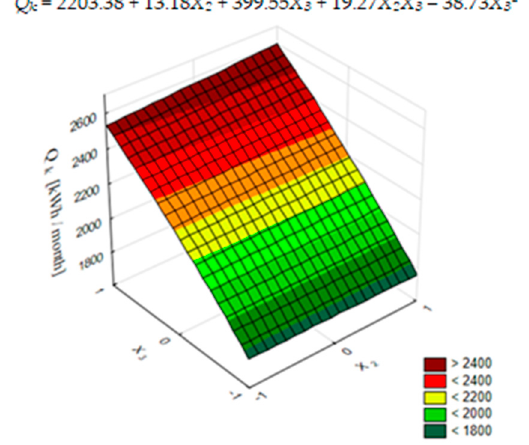
Figure 13. Dependence of the monthly final energy demand Q k (kWh / month) of the tested building on the length of the residents’ self-isolation period τ (factor X 2 ) and number of residents in the house N (factor X 3 ) at values m = 1 (January); r = 0 (gas).